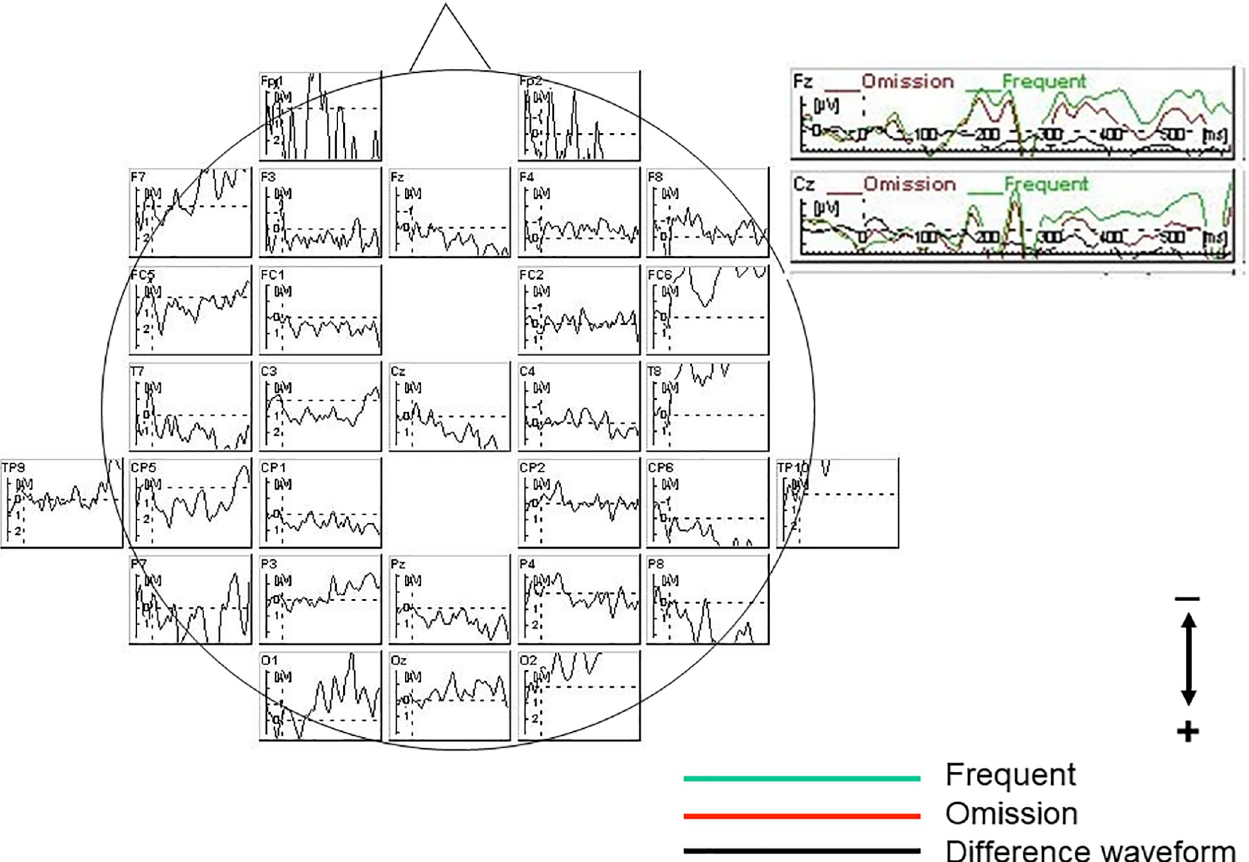
Fig 2. Grand average waveform of controls. Omission events elicited an event-related potential (ERP) component recognized as mismatch negativity (MMN) around latency ranges of 120–185 ms in controls.